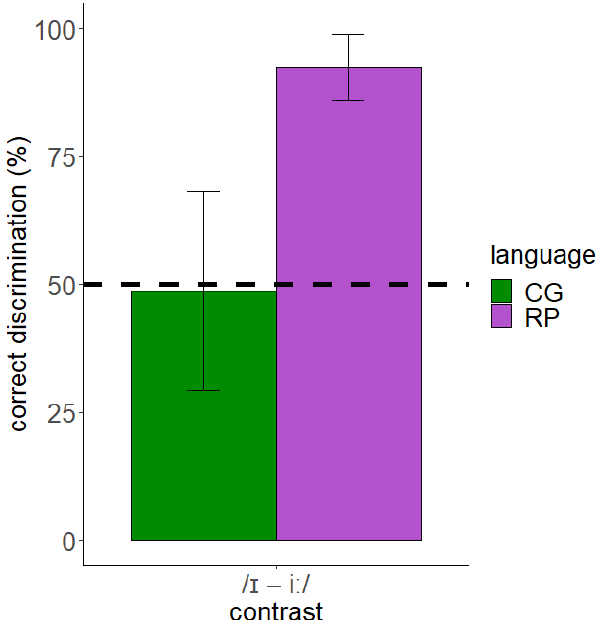
Figure 2. Discrimination accuracy of the English / ɪ /–/i ː / contrast by CG and RP speakers (dashed line shows chance performance).